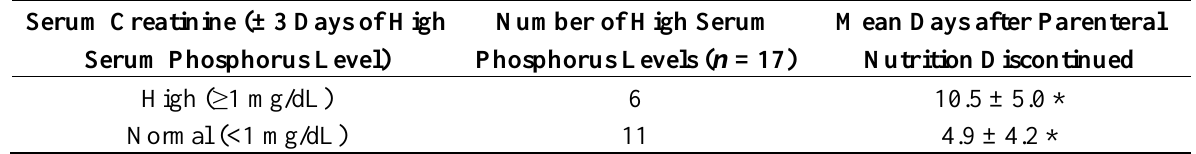
Figure 2. Comparison of creatinine levels in early vs. late hyperphosphatemia. Table 5. Comparison of serum creatinine and high serum phosphorus